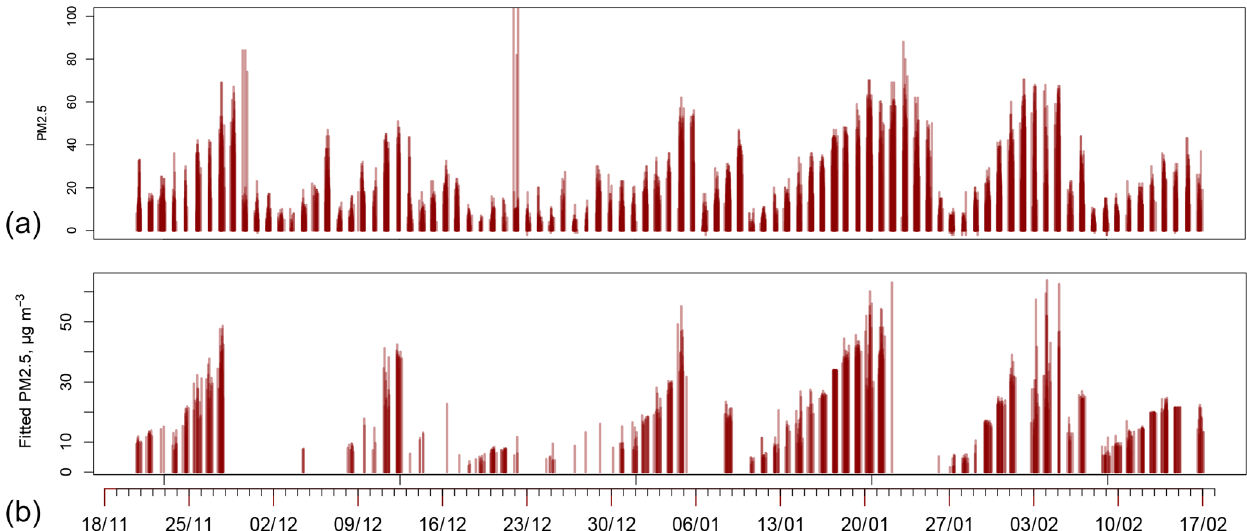
Figure 4. (a) PM 2 . 5 as observed at all stations for the winter period extending from November 2012 to March 2013. The graph has vertical bars drawn with partial transparency, so that careful inspection of a single day describes all the observations in the valley for the day. The observations contributing for each day may be seen in Fig. 3b. (b) PM 2 . 5 as fitted by the regression with slopes and intercepts, described further